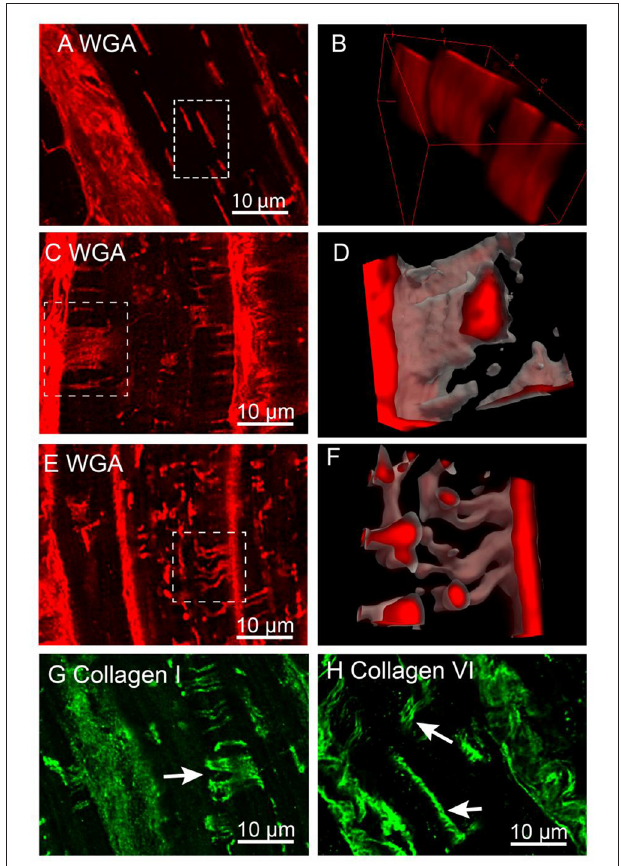
FIGURE 5 | Confocal imaging of t-sheets in the IDCM human heart. (A) WGA labelling of t-sheets that superficially appear as axial tubules in the single-plane image. (B) 3D projection of the white rectangular region from “ (A) ” confirm the presence of sheet-like structures. (C) Confocal stack Z-projection 1.5 µ m deep of in-plane WGA labelled t-sheet (white arrow). (D) 3D projection of t-sheet from “ (C) ”. (E) Confocal stack Z-projection 1.5 µ m deep of WGA labelling indicating the presence of two t-tubules that have appeared to fuse (white arrow). (F) 3D projection of fused t-tubules from “ (E) ”. (G) Confocal stack Z-projection 1.5 µ m deep of collagen I labelling of t-sheets (white arrow). (H) Confocal stack Z-projection 1.5 µ m deep of collagen VI labelling of t-sheets (white arrows). For each label n = 5 IDCM hearts, 3 cells were imaged from each